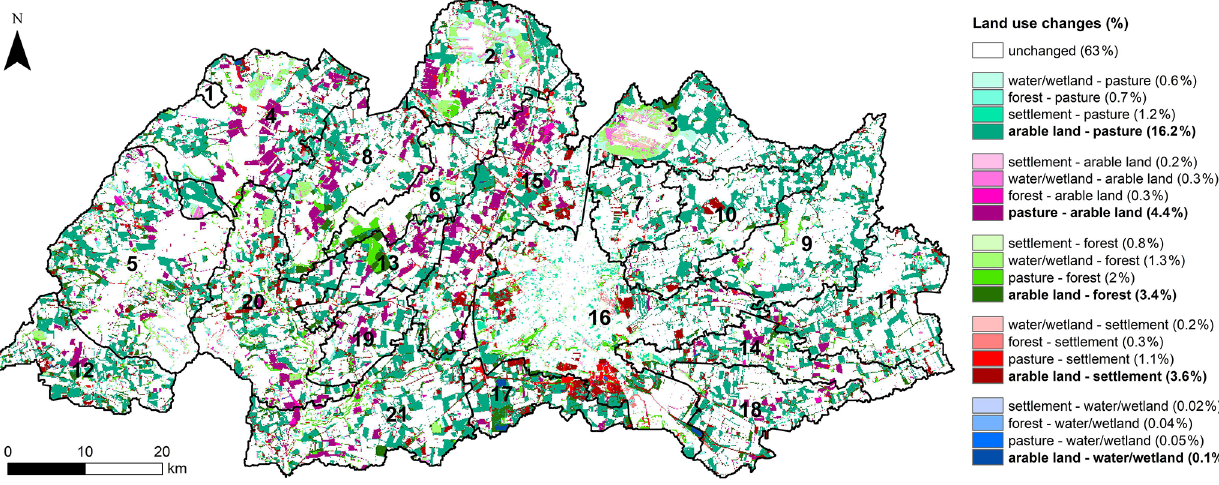
Hydrol. Earth Syst. Sci., 26, 2561–2582, 2022